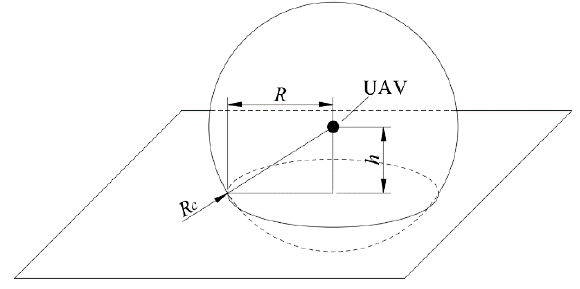
Figure 2. The schematic of the communication coverage area of a UAV on the ground.